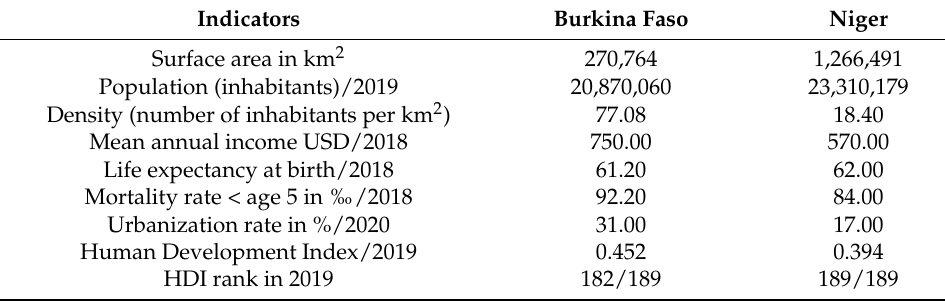
Table 1. Presentation of the Burkina and Niger